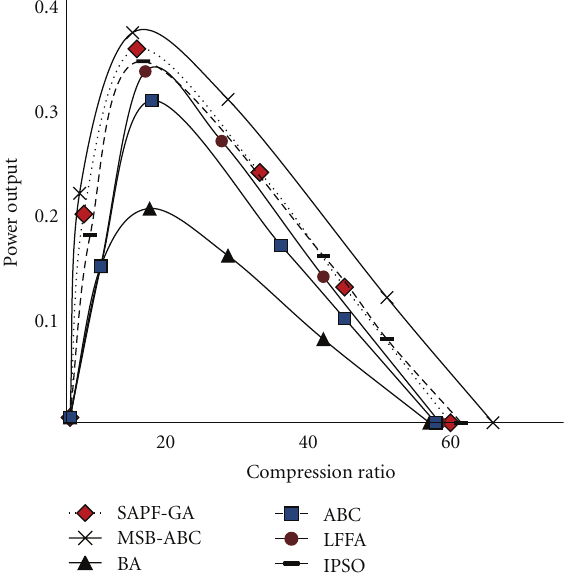
Figure 11: Performance of tested algorithm in γ 0 = 1 . 36 and k 1 = 0 . 00006.